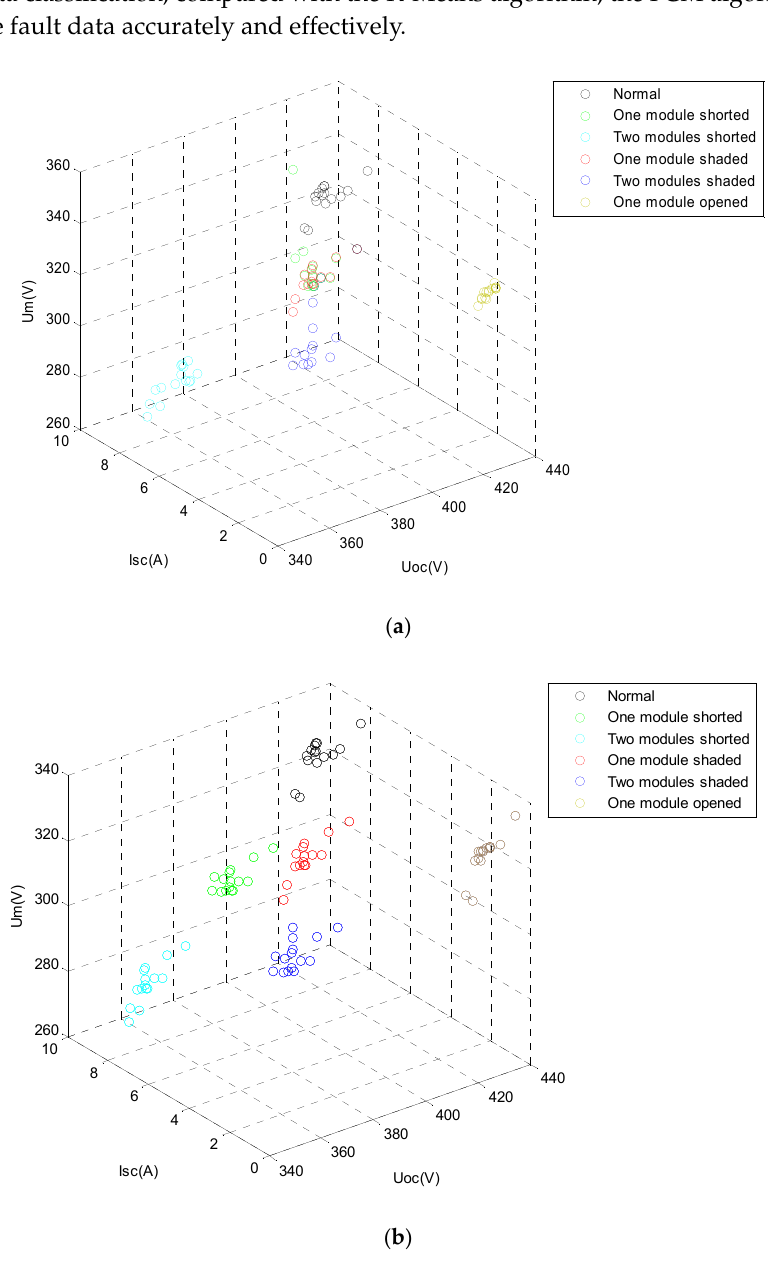
Figure 8. Comparison of clustering results, ( a ) Clustering analysis results of six fault states based on K-Means algorithm; ( b ) Clustering analysis results of six fault states based on FCM algorithm.